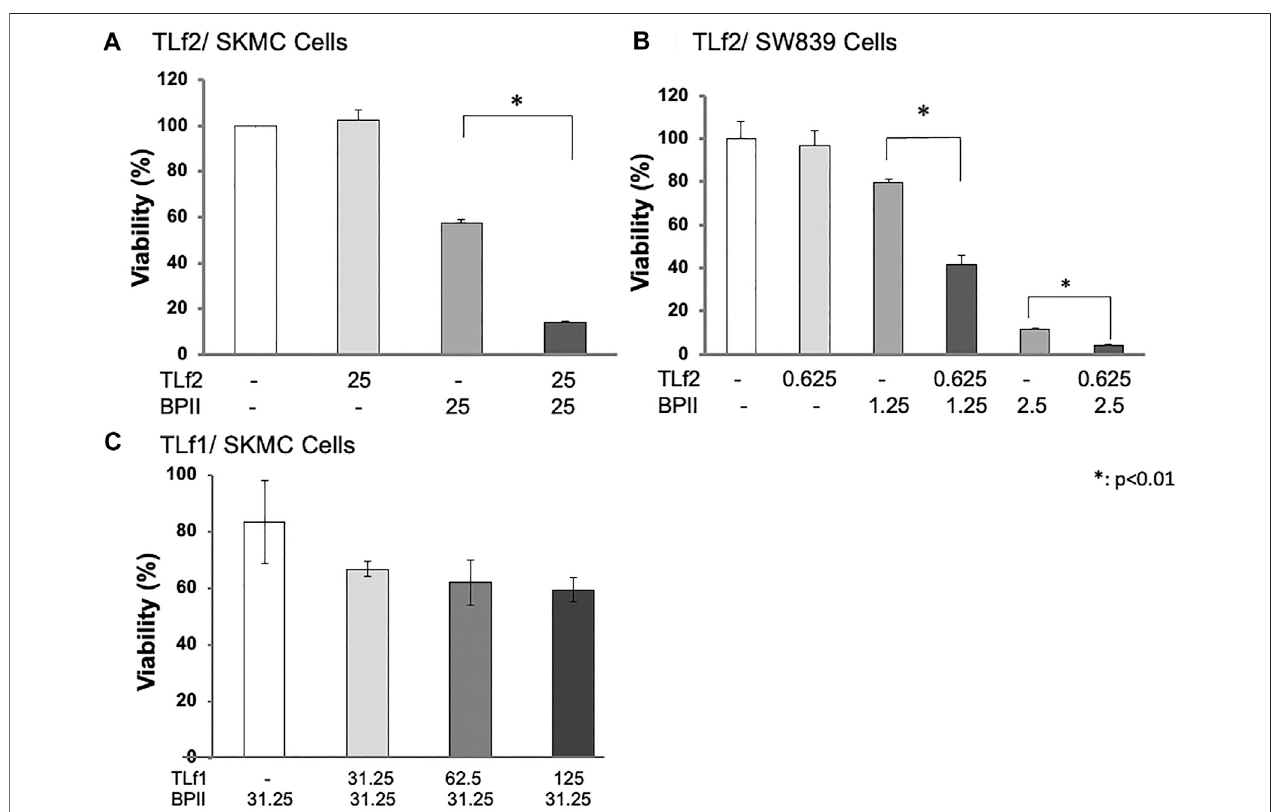
FIGURE5| SynergicenhancingactivityofTfL2andTLf1oncytotoxicityofBPIIagainstSkMC (A,C) andSW839cells (B) .SW839andSkMCcellswereinoculated into 96-well microtiter plates (1.0 × 10 5 cells/well), and treated with [Lys49] PLA2 (BPII) and TLf2 or TLf1 for 24 h at various concentrations ( μ g/mL). Cell viabilities were analyzed using Cell Counting Kit-8 (WST-8). All measurements were conducted in triplicate. The data were evaluated by using Student ’ s t-test. *: p < 0.01.